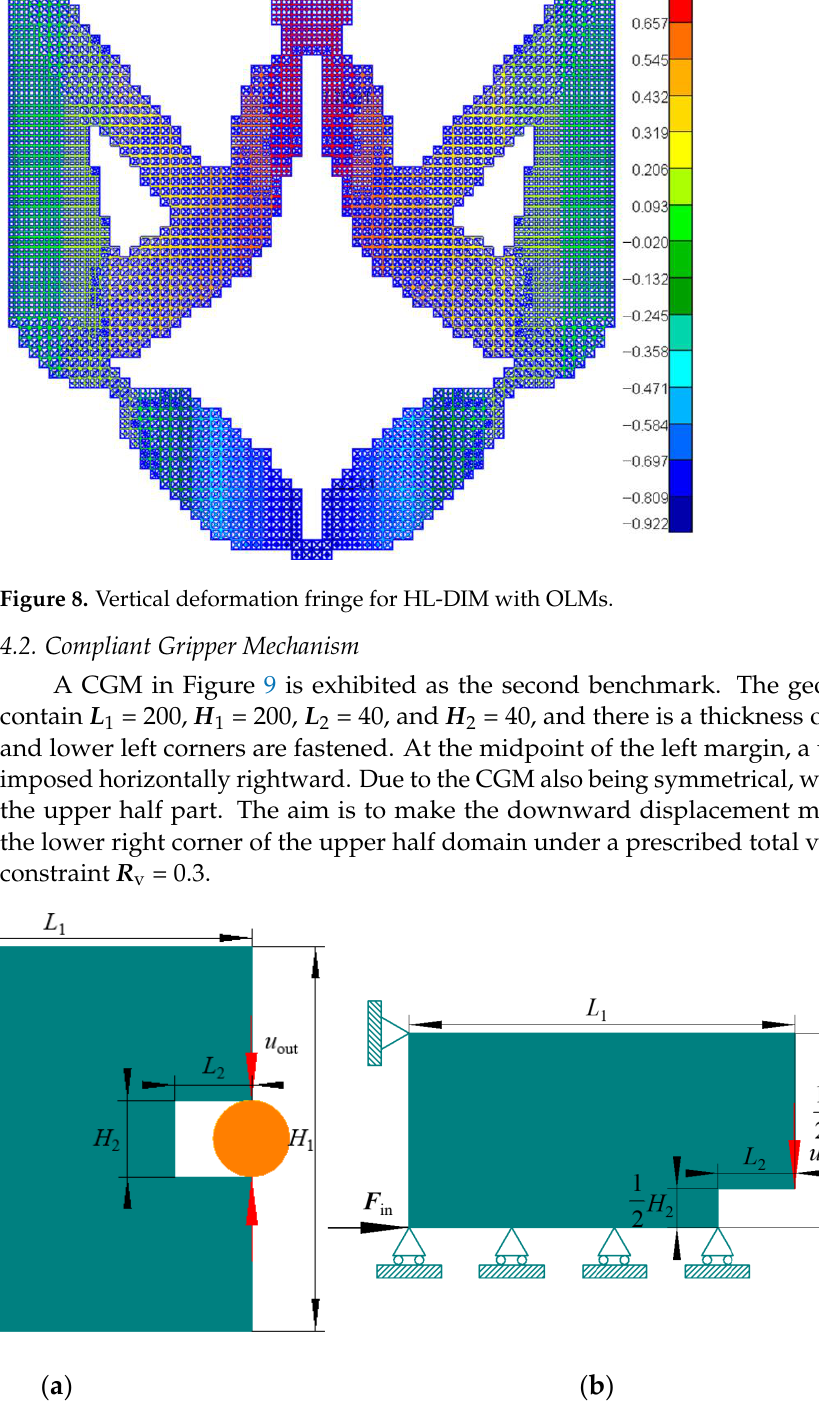
Figure 7. Objective output displacement comparison for different DIMs.